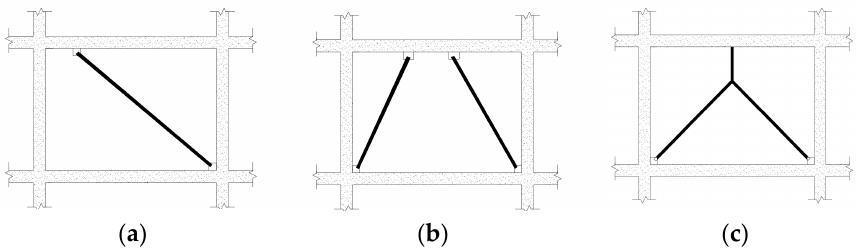
Figure 2. Several schematic models with eccentric bracing systems: ( a ) single diagonal bracing with eccentricity, ( b ) double diagonal bracing with eccentricity, ( c ) Λ bracing with eccentricity